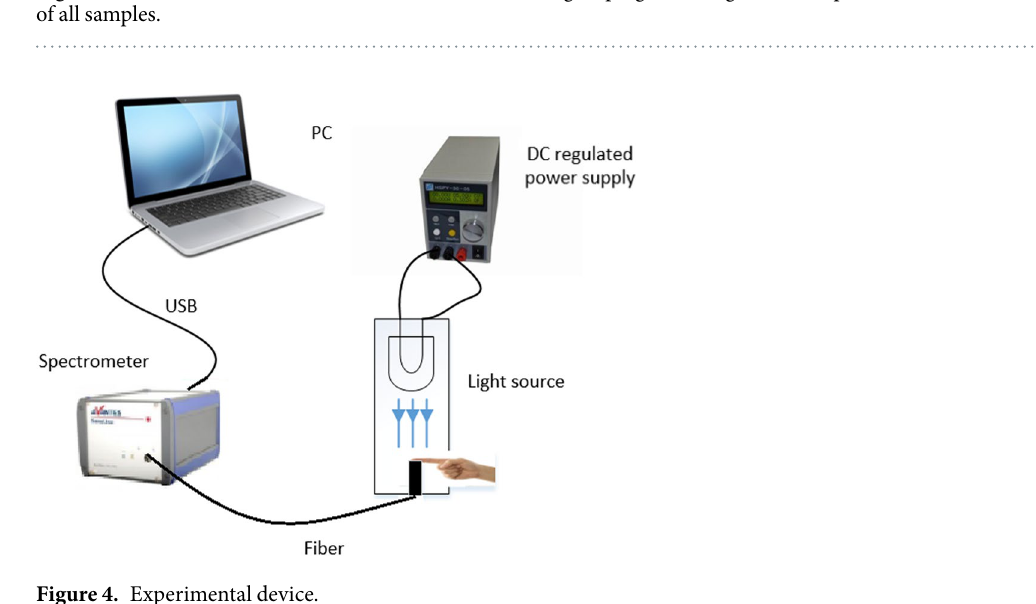
Figure 4. Experimental